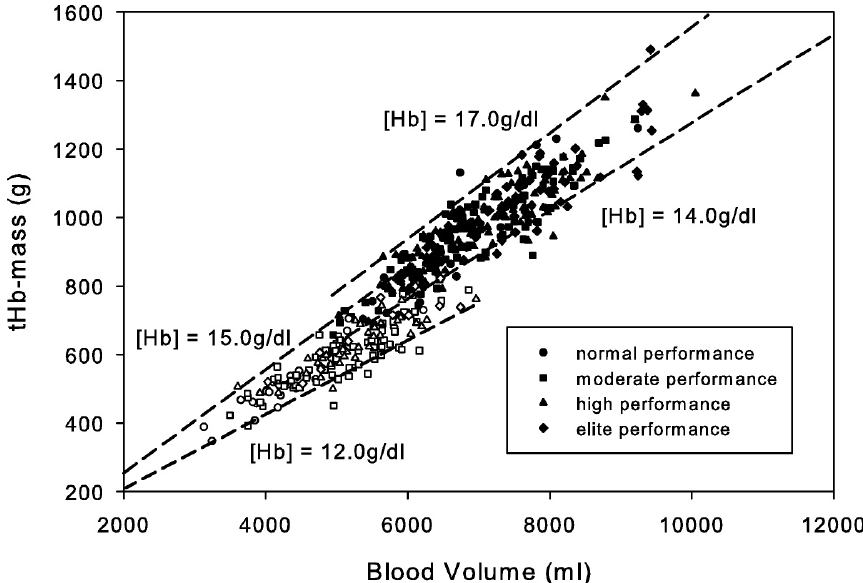
Figure 6. Reprinted with permission from ref. [69]. 2010 American College of Sports Medicine. Data are from 490 subjects (male n = 314, closed symbols; female n = 176, open symbols). Endurance state is classified by VO 2max . The dashed lines indicate hemoglobin concentration as a function of blood volume and hemoglobin mass.